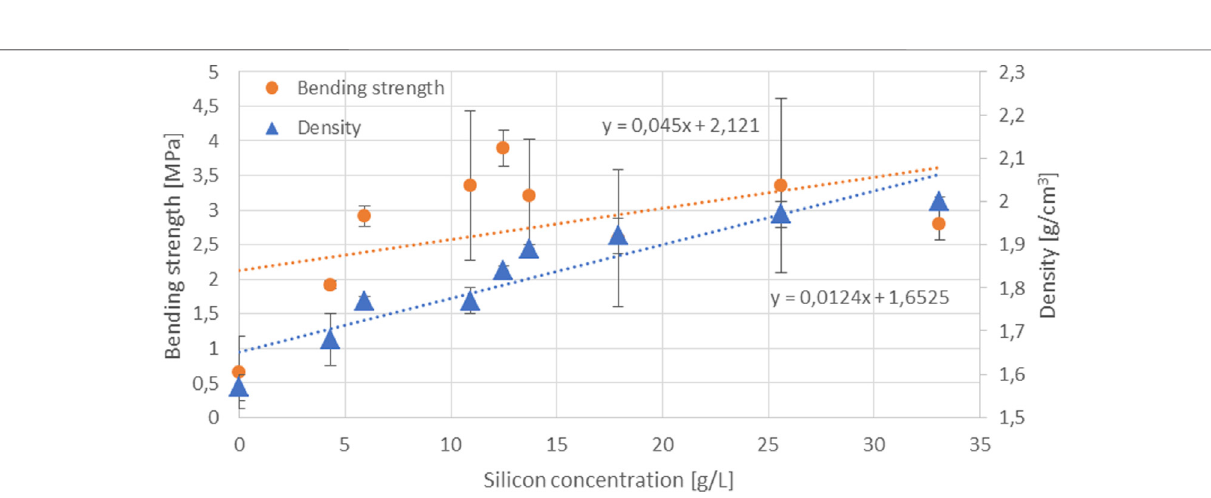
Frontiers in Materials |